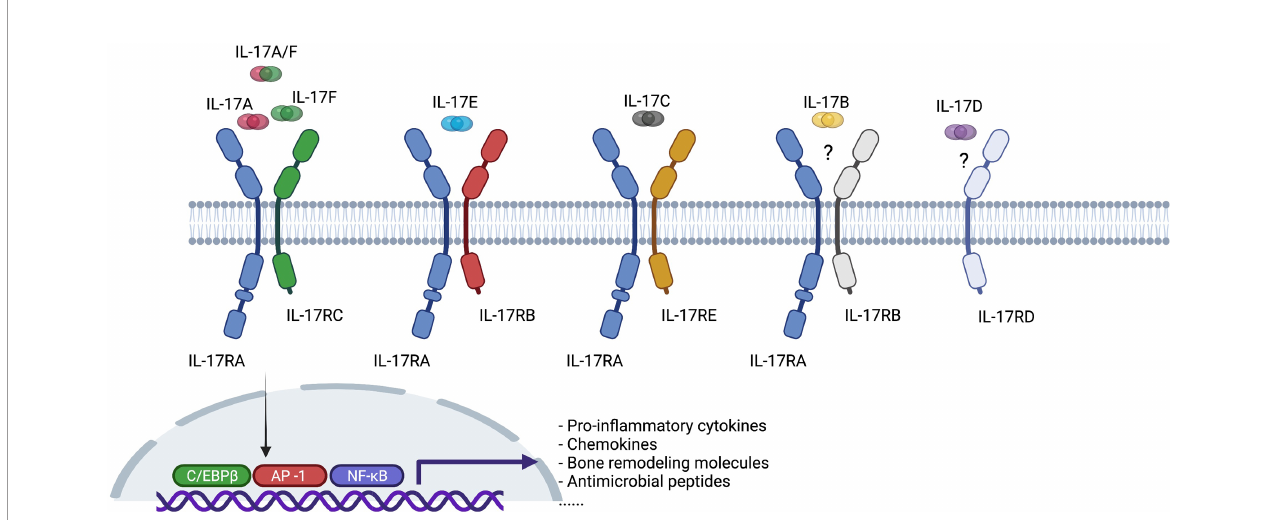
FIGURE 2 | Interleukin-17 (IL-17) cytokine family and interleukin-17 receptor (IL-17R) family. C/EBP b , CCAAT-enhancer-binding protein beta; AP-1, activator protein-1; NK- k B, nuclear factor kappa